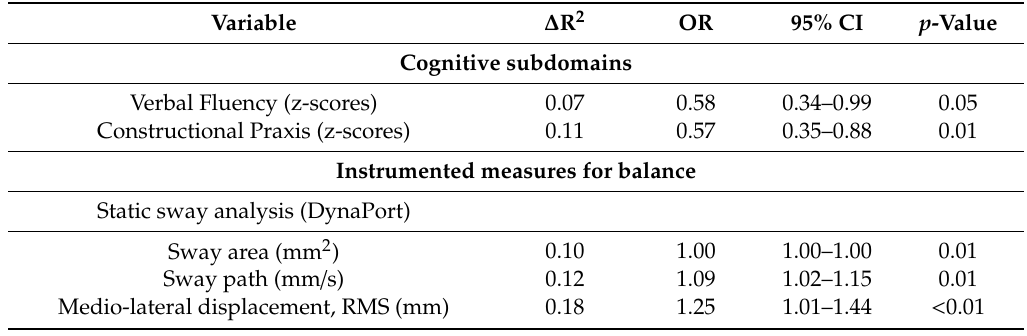
Table 3. Results of the univariate logistic regression and area under the receiver operating characteristic curve (AUC) analysis.